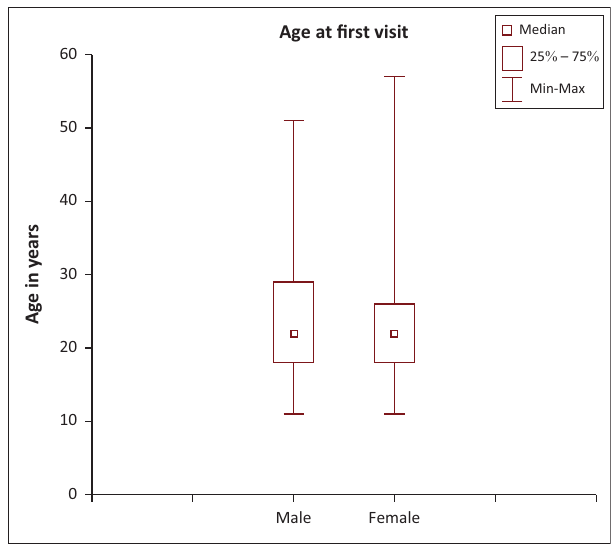
FIG URE 2: Box and whisker plots for the age at first visit for 97 males and 109 females. Medians, interquartile ranges and minimum and maximum ages are given. According to the Student t -test there was no significant difference in age between male and female patients ( p > 0.05).